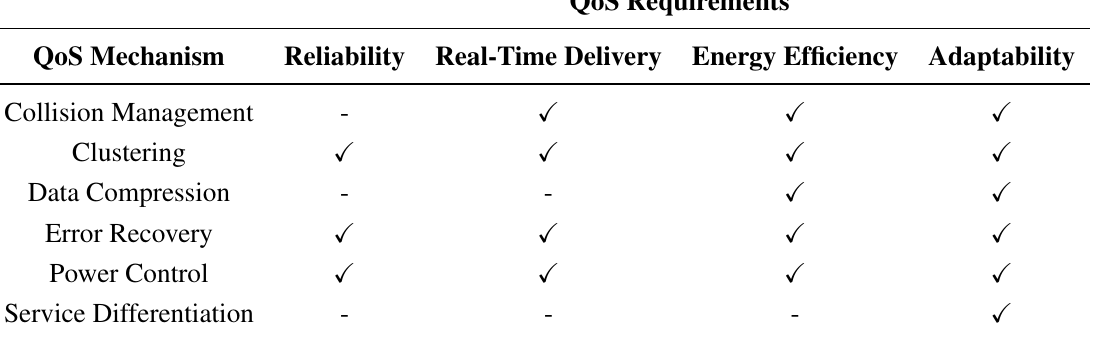
Table 4. QoS mechanisms and the QoS requirements addressed by